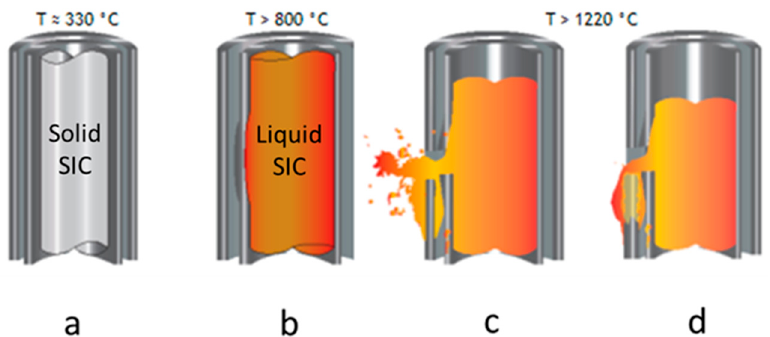
Figure 2. Degradation of the SIC absorber rod in a low-pressure accident scenario ( a ) in nominal conditions constituted of SIC alloy encapsulated in a stainless steel cladding, itself surrounding by a Zircaloy guide tube ( b ) pressure augmentation and progressive swelling of the stainless steel cladding ( c ) rupture of the rod ( d ) relocation of the absorbing materials.